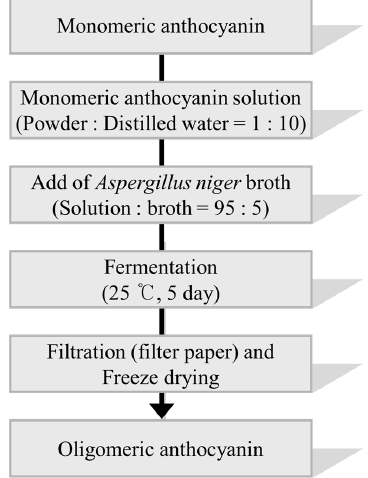
Figure 1. The flow chart of oligomeric anthocyanin synthesis using Aspergillus niger .